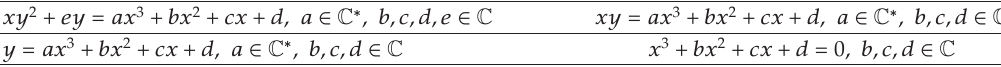
Table 2: Complex cubic curves which are not complex Hessian